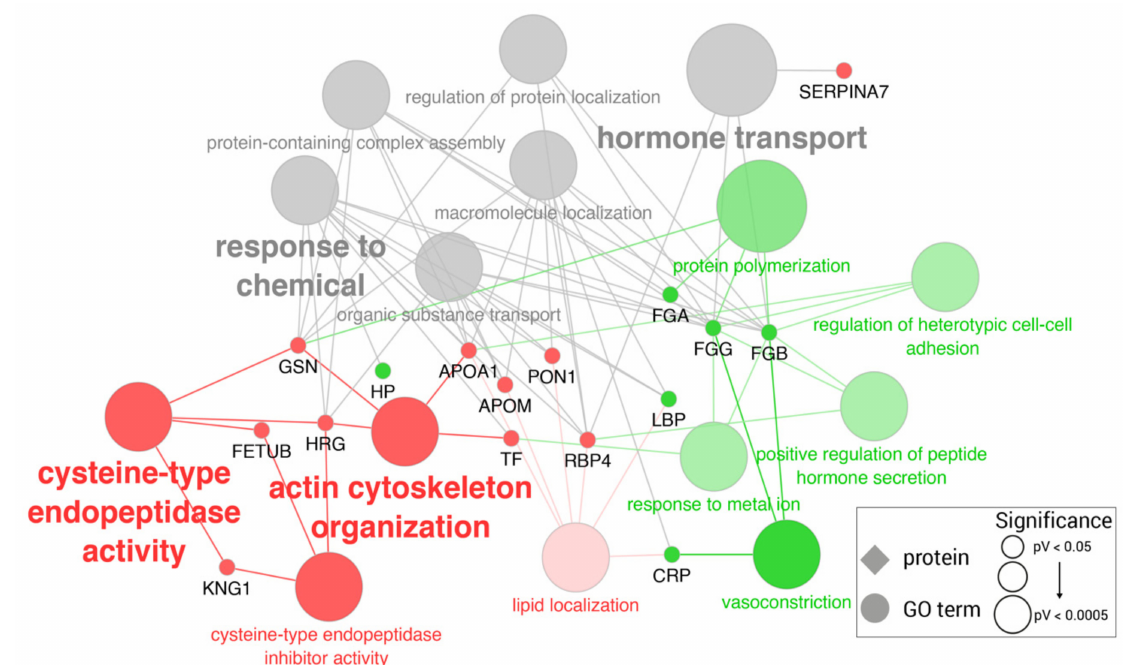
Figure 4. Significantly enriched GO terms among differentially expressed proteins in the serum of pigs with non-septic inflammation. Edges link proteins (diamonds) to their associated GO terms (circles). Proteins are colored in green if overexpressed or in red if down-expressed. GO terms are colored accordingly to the proportion of over-/down-expressed proteins. GO term shape and font size is proportional to GO term significance, but all included ones showed a p value <